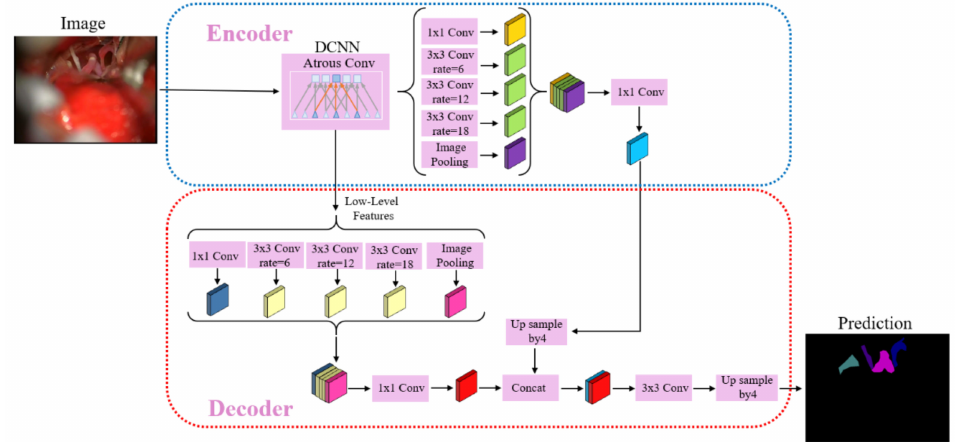
Figure 1. The structure of the semantic-segmentation network for microvascular decompression